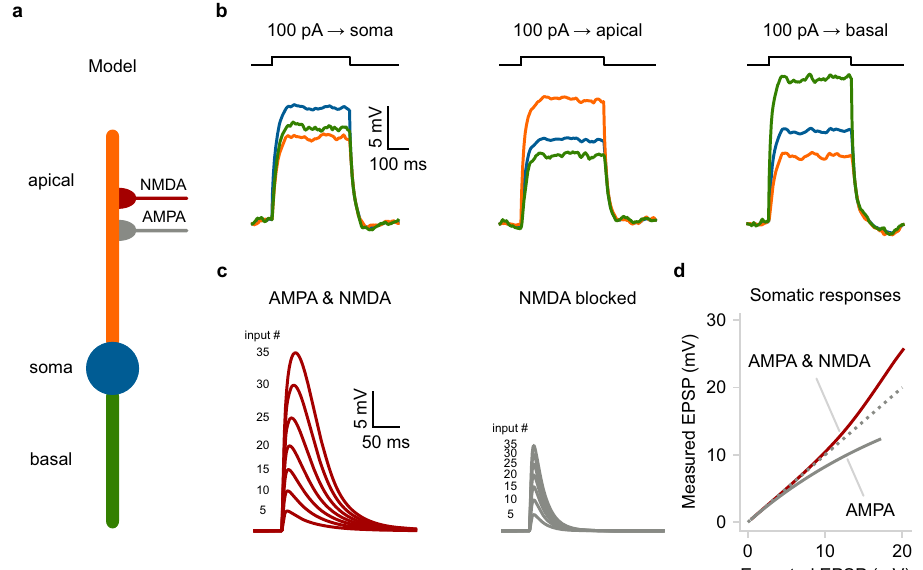
Fig. 2 | A basic compartmental neuron model with passive dendrites. a Schematic illustration of a compartmental model consisting of a soma (spiking unit) and two dendrites (passive integrators). The apical dendrite can integrate excitatory synapses comprising AMPA and NMDA currents. b Membrane voltage responses to current injections of the same amplitude are applied individually to each compartment. Notice the electrical segregation caused by the resistance between the three neuronal compartments. c Somatic responses to a varying